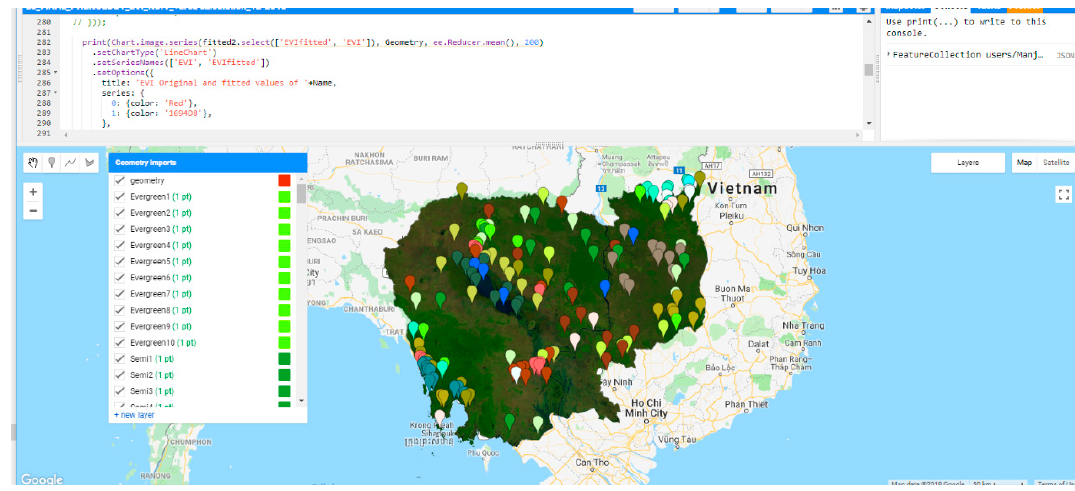
Figure 2. Shows the 120 geometry locations of 12 land cover categories in GEE which we geolocated based on the reference data and visual interpretation by referring to forest cover data from 2000 and 2006. The temporal EVI chart function presented is in the code editor section. In the main map window, the background image is an OLI TOA composite image (band combination of B6, B5, and B4).